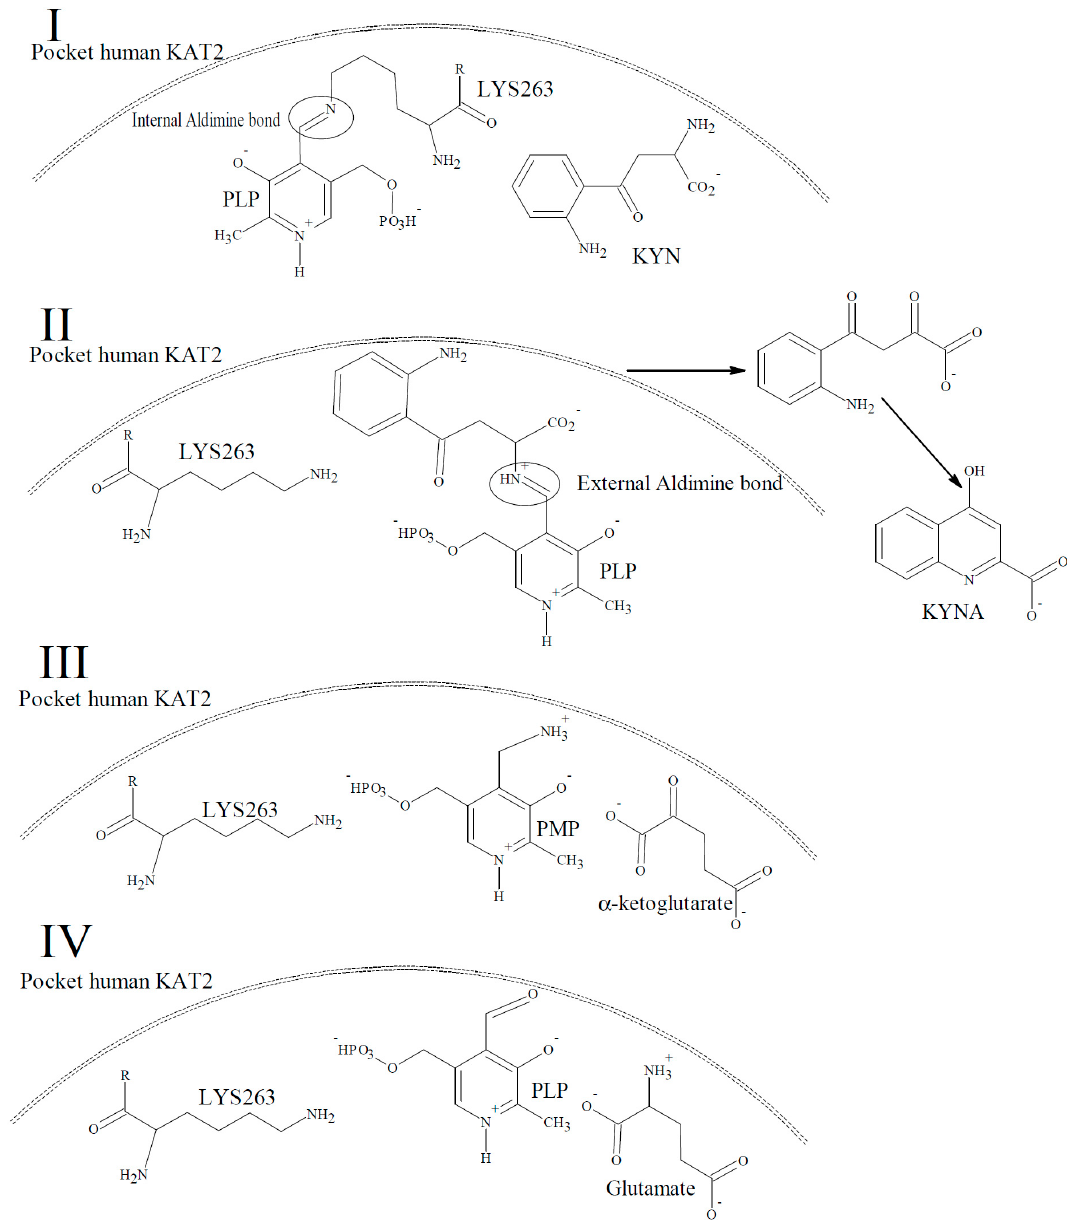
Figure 2. The mechanism of the human KAT-2 catalytic cycle. ( I ) PLP is covalently bound to LYS263 in the reaction pocket of human KAT-2 by an internal aldimine linkage in the native form of the enzyme; ( II ) The α -amino group of KYN in the active site binds to PLP via an external aldimine bond, and breaks the internal aldimine bond. Spontaneously ring closure of the α -keto analogue yields KYNA. ( III ) The α -amino group of the external aldimine bond from the previous step is transferred to the PLP, and of the production of KYNA simultaneously allows the formation of pyridoxamine phosphate (PMP); ( IV ) The regeneration of PLP from PMP is accomplished by converting the co-substrate, α -ketoglutarate, to glutamate by transferring the amino-group of PMP to the α -ketoglutarate, and consequently the PLP-form of the enzyme (I) is regenerated.